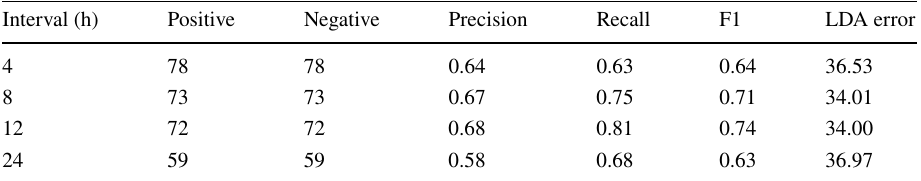
Interval (h) Positive Negative